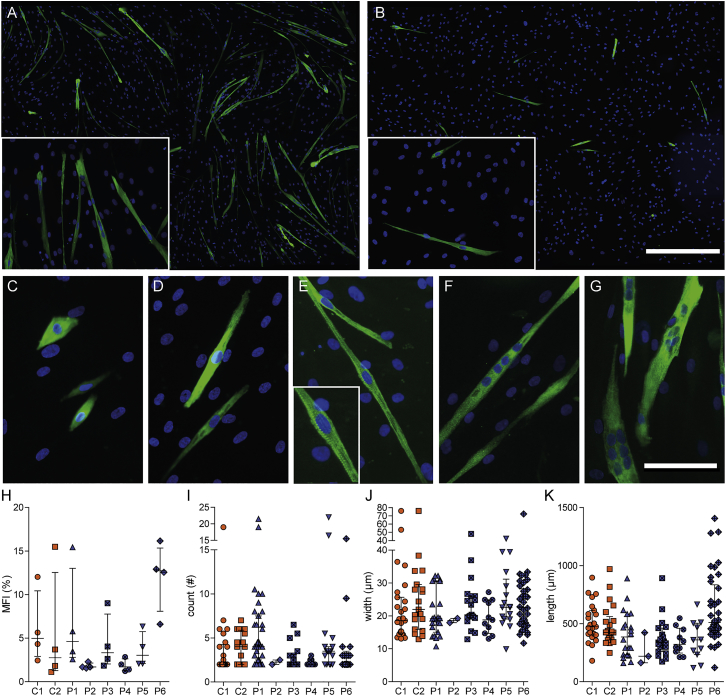
Myogenic Potential of DM1 Patient and Control PericytesHuman pericytes were cultured under low-serum conditions and stained for differentiation marker MHC (green) and DNA (blue). Overview of a relatively efficient (A) and inefficient (B) differentiation culture. Scale bar in (A) and (B), 500 μm. (C–G) Typical cell morphologies and features that were observed in the cultures: roundish (C) and elongated (D) mononuclear cells; mononuclear cells with typical striated sarcomeric features (E); long multinucleated myotube (F); multinucleated myosac (G). Scale bar in (C)–(G), 100 μm. Differentiation cultures of each pericyte isolation were separately analyzed for MFI (H), number of nuclei per myotube (I), myotube width (J), and myotube length (K). Each data point represents the average MFI per culture (n = 4) (H), the number of nuclei per one myotube (n = 2–35) (I), width of one myotube (n = 2–38) (J), and the length (n = 3–37) (K). Bars indicate median with interquartile range.